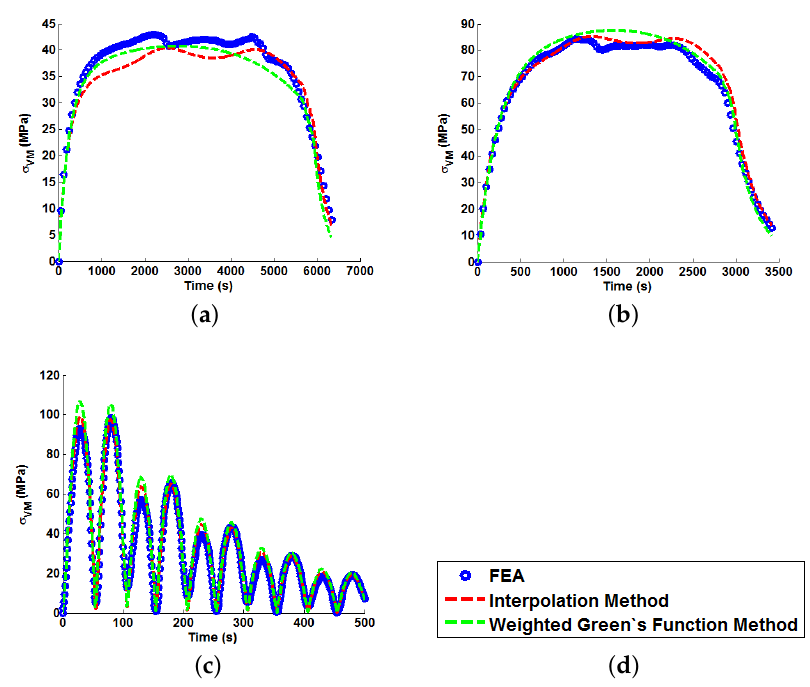
Figure 13. Predictions of thermal stress responses determined using the interpolation and weighted Green’s functions methods for: ( a ) ramp up Profile G; ( b ) ramp up Profile H; and ( c ) oscillating Profile I. Sub figure ( d ) shows the legend used in the